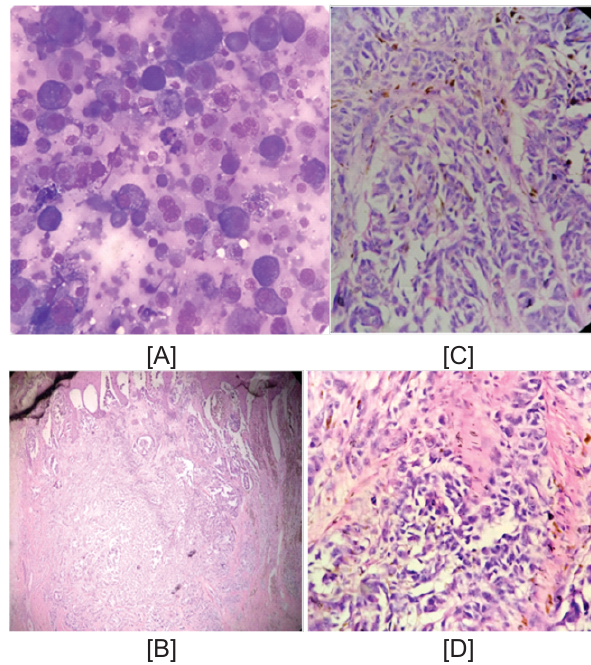
Figure: FNAC from the skin nodule [A]; skin biopsy from nodule [B, C,